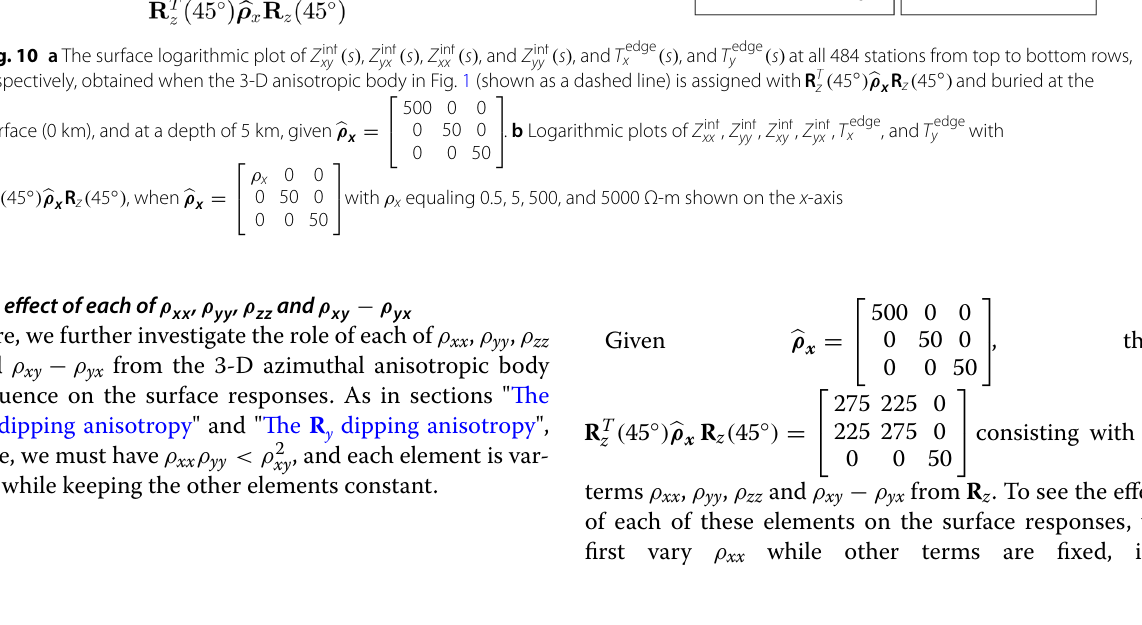
first vary ρ xx while other terms are fixed, i.e.,